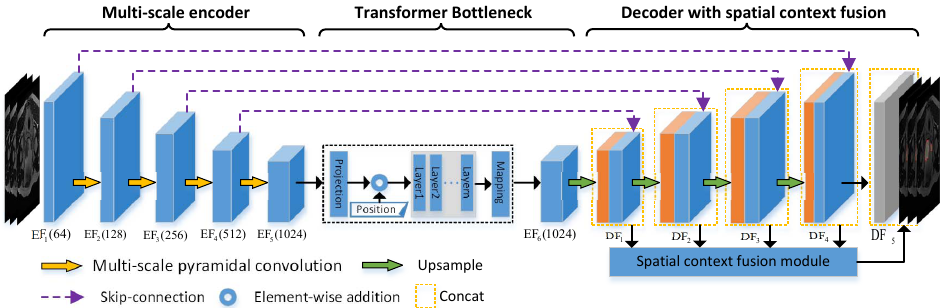
Figure 2. The architecture of MSEDTNet, which is composed of an encoder, bottleneck, decoder and skip